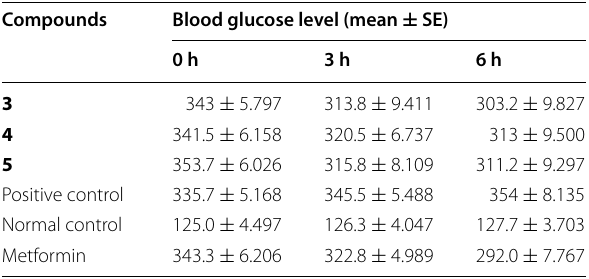
Table 1 Blood glucose level in experimental animals